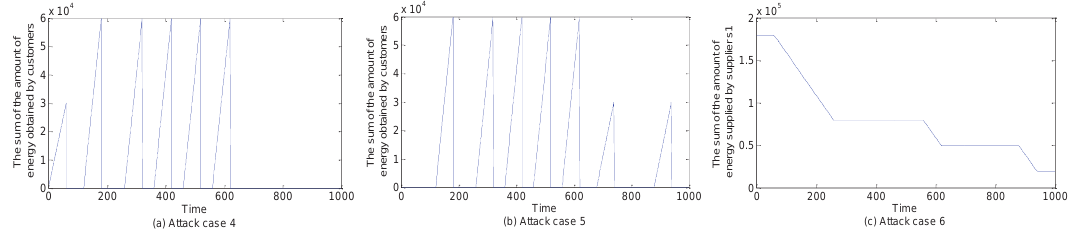
Figure 15. Impact of attack case 4, attack case 5, and attack case 6.